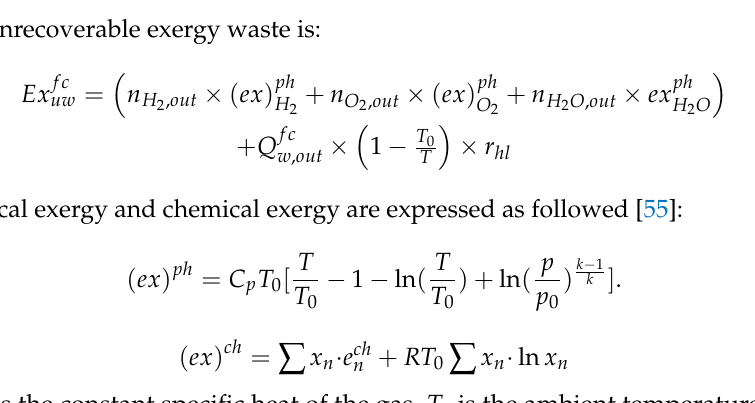
Figure 6. Exergy balance of proton exchange membrane fuel cell.